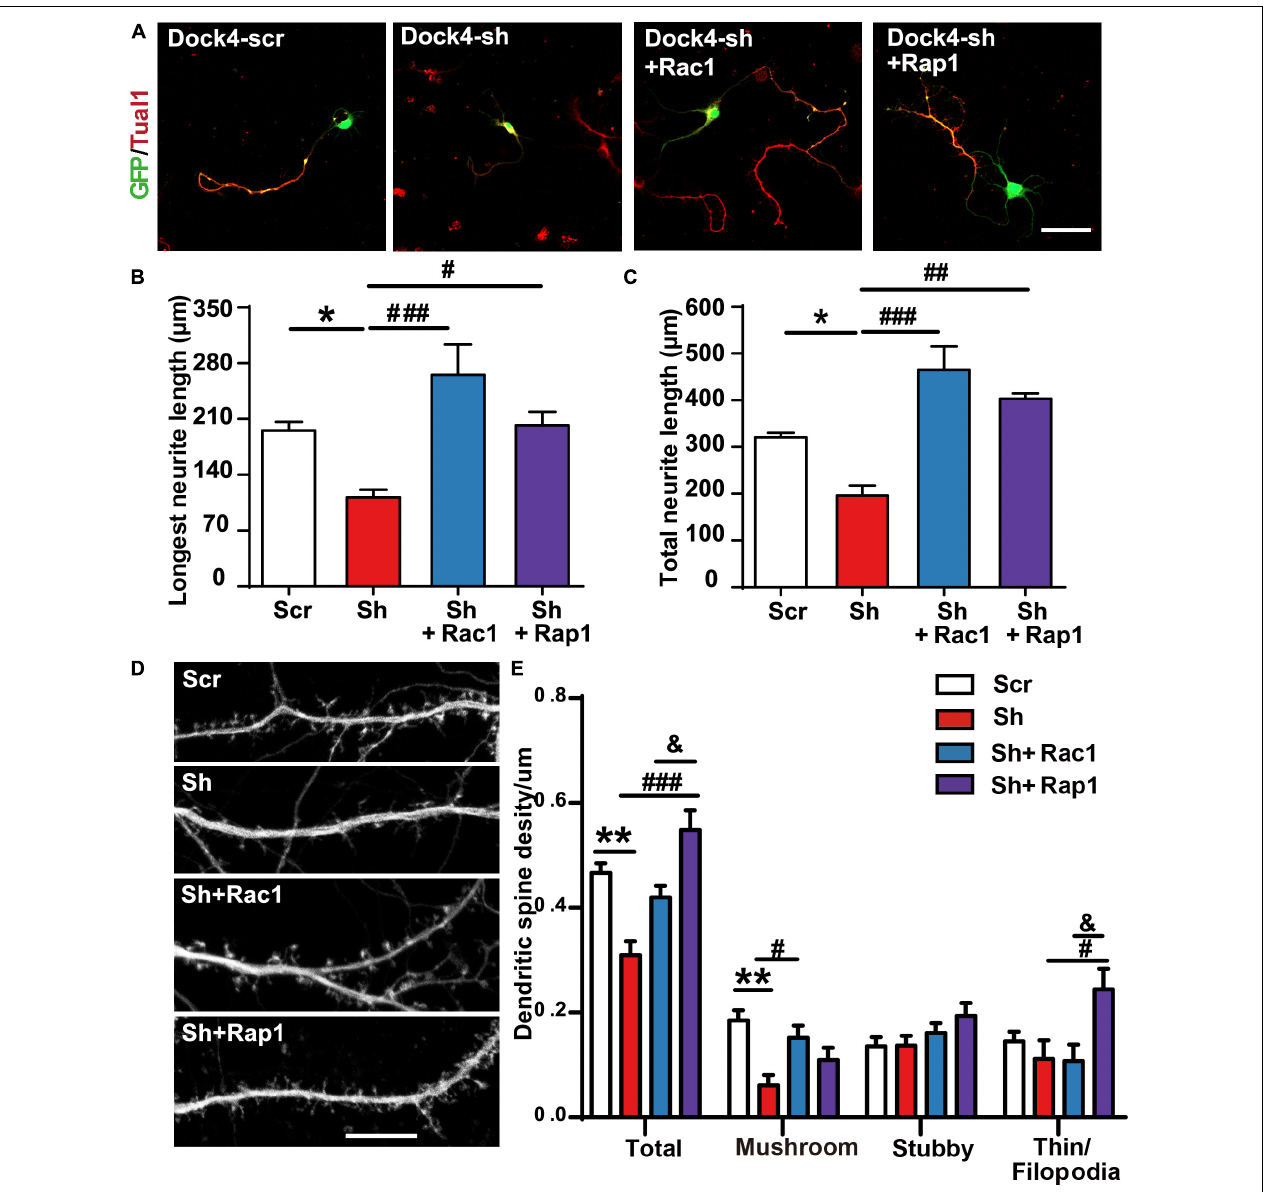
FIGURE 7 | Rac1 and Rap1 rescue the defects of neurite outgrowth and spine morphogenesis in Dock4 knockdown neurons. (A) Rac1 and Rap1 rescue neurite outgrowth defects in Dock4-knockdown hippocampal neurons. Dissociated E18 hippocampal neurons were transfected with plasmids expressing Dock4-scramble shRNA (Scr), Dock4-shRNA (sh), sh + Rac1, or sh + Rap1, and cultured for 3 days. Axon-like processes were immunostained with Tau1 (red) antibody, and transfected cells were indicated by GFP. Scale bar, 50 µ m. Average length of the longest neurite (B) and total neurites (C) was measured. ∗ P < 0.05, # P < 0.05, ## P < 0.01, ### P < 0.001, one-way ANOVA. At least 40 cells/group were analyzed in each experiment. (D) 9 DIV hippocampal neurons were transfected with plasmids expressing Scr, sh, sh + Rac1, or sh + Rap1. Spine morphology was analyzed at 16 DIV. Scale bar, 10 µ m. (E) Densities of total spines and different types of spines were measured. Data are shown as mean ± SEM from three independent experiments. ∗∗ P < 0.01, # P < 0.05, ### P < 0.001, & P < 0.05, one-way ANOVA. At least 20 cells/group were analyzed in each